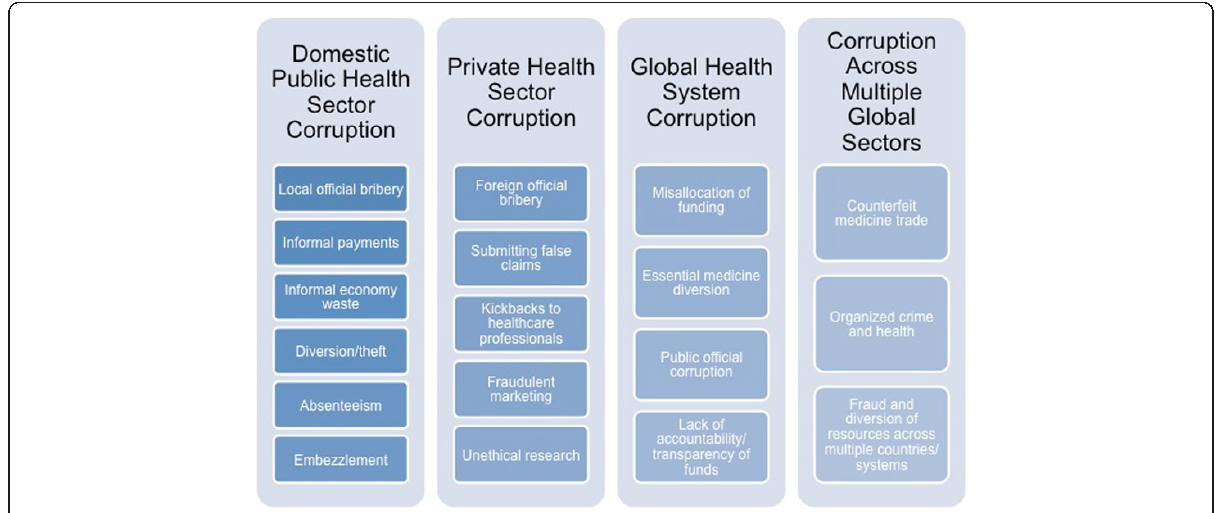
Figure 1 Examples of health corruption types and